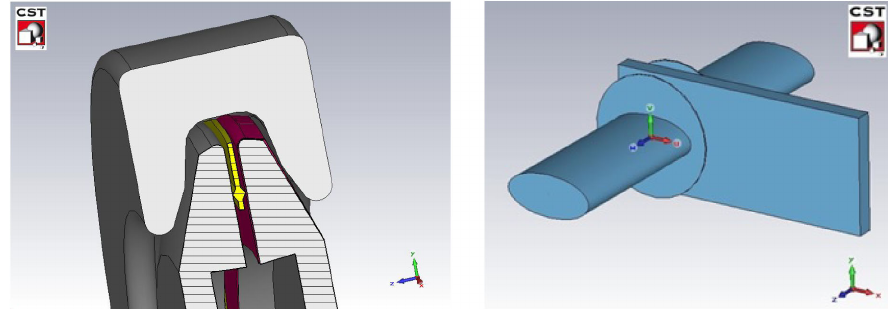
FIG. 7. 3D model of a PS flange used for CST Particle Studio simulations (left); 3D model of a PS sector valve used for CST Particle Studio simulations